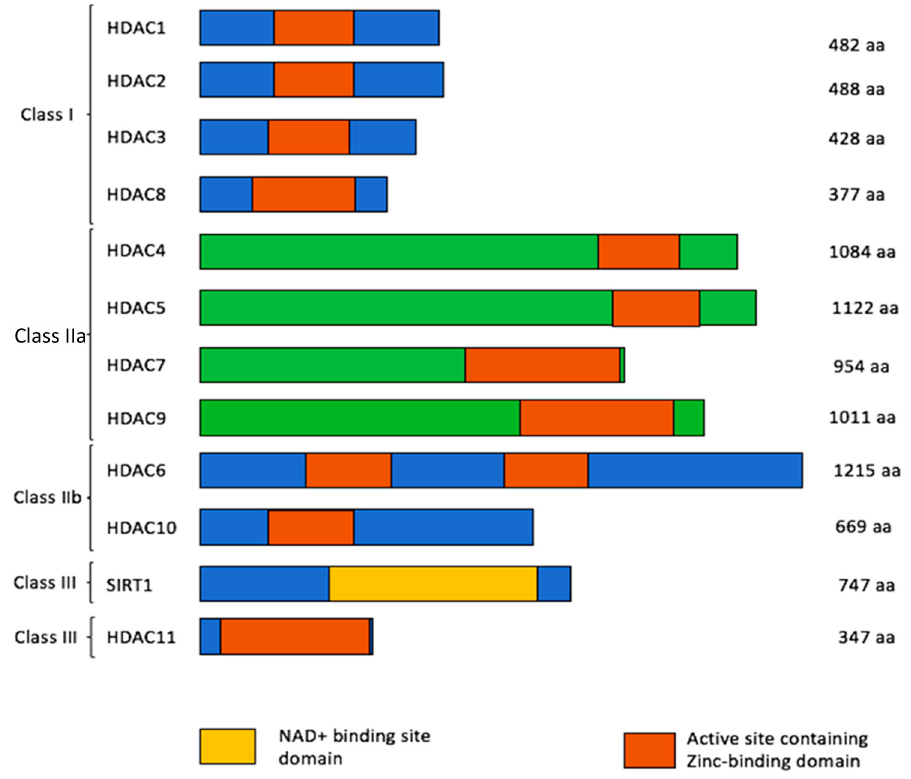
Figure 2. The different classes of HDACs. The color scheme represents the active site containing the zinc-binding domain and NAD+ binding site domain [18].